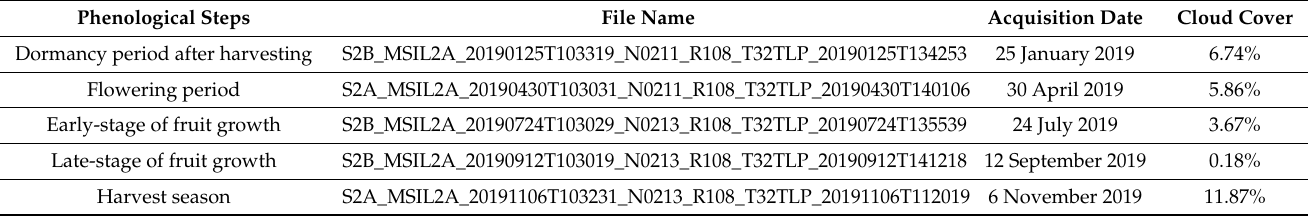
Table 1. Earth Observation data selection and their corresponding phenological stage.